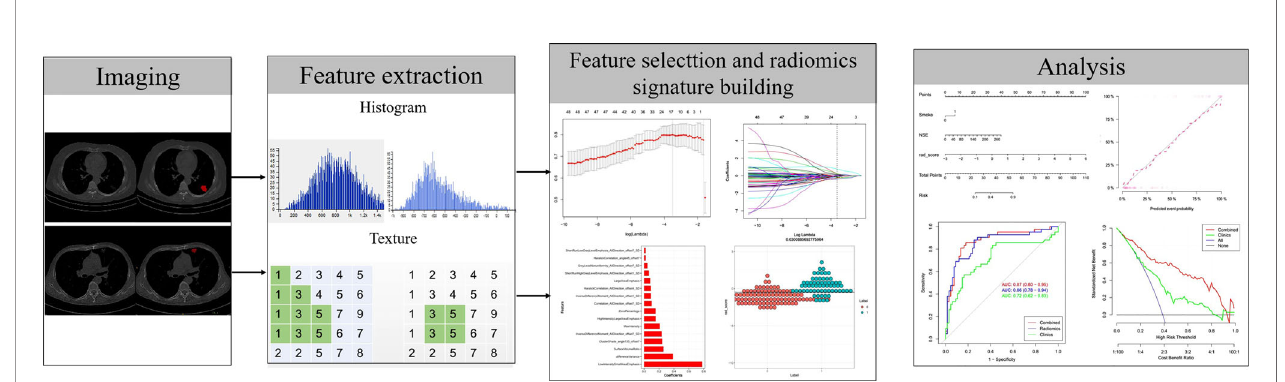
FIGURE 2 | Flowchart of radiomics implementation in this